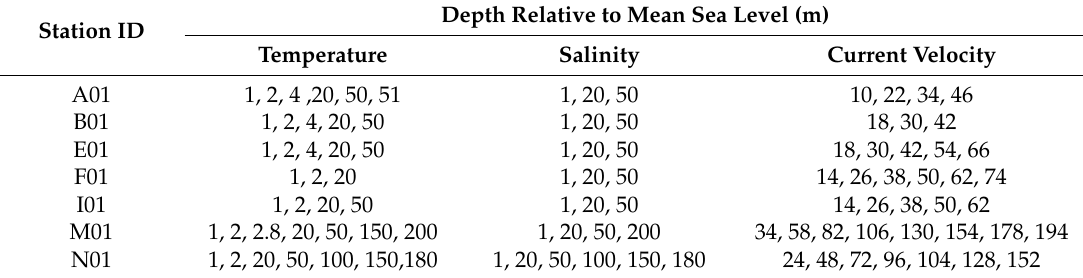
Table 1. Measurement depths of water temperature, salinity, and current velocity at the NeraCOOS